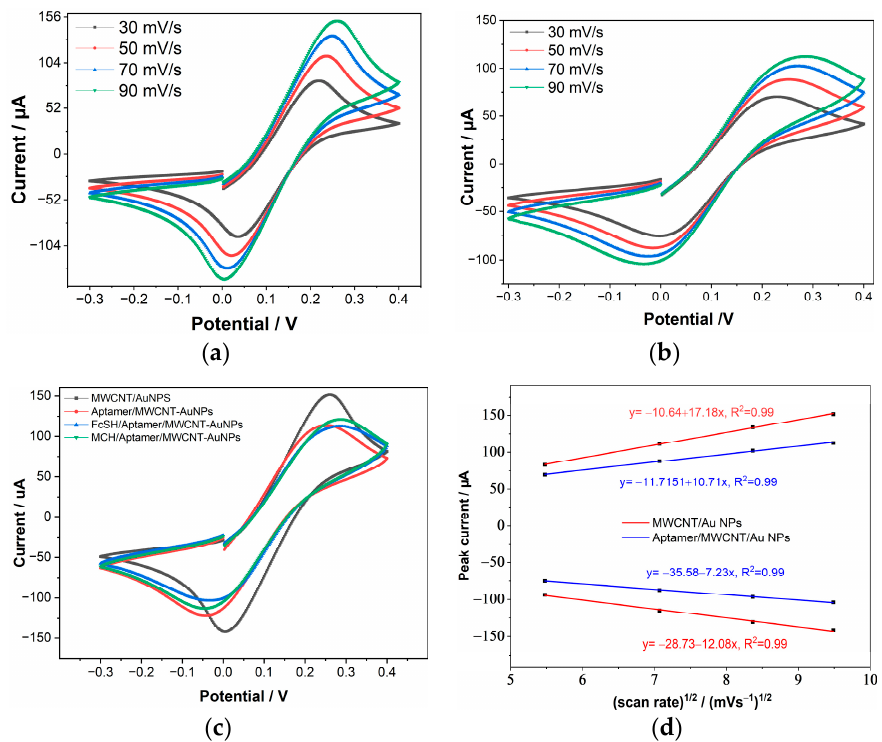
Figure 2. Cyclic voltammetry results of the: ( a ) MWCNT/AuNP; ( b ) Immobilized MWCNT (ap- tamer/MWCNT/AuNP), ( c ) MWCNT-AuNPs, aptamer/MWCNT-AuNPs, FcSH/aptamer/MWCNT- AuNPs and MCH/aptamer/MWCNT-AuNPs, ( d ) the relation between the current and the square root of scan rate.